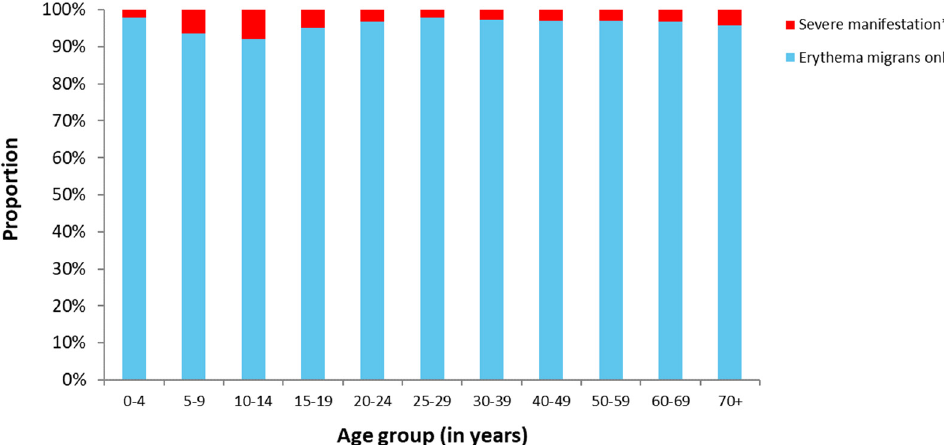
Figure 3. Proportion of LB cases reported between 2013 and 2020 in Bavaria, Germany, by severity of manifestation and age group ( n = 34,840 with information on age available; * Severe manifestations were defined as reported LA, radiculoneuritis, meningitis, and neuritis cranialis). Univariable analysis showed that children aged 5–9 years had significantly increased odds of developing meningitis (odds ratio (OR): 3.4; 95% confidence interval (CI): 2.2–5.2; Table 2) as well as neuritis cranialis (OR: 4.6; 95% CI: 3.6–6.0) compared to all other age